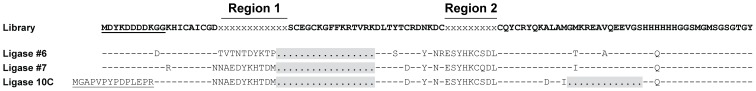
Sequence alignment of the library used as input for the original ligase selection with ligases #6, #7 [17] and 10C that were selected at 23°C and at 65°C, respectively [41], [42].The amino acids in regions 1 and 2 of the original library (on top) were randomized prior to the selection at 23°C and are shown as “x” [43]. Dashes symbolize amino acids that are identical to the starting library. A period highlighted in gray represents a deletion. The underlined N-terminal amino acids of the library and ligase 10C represent a Flag epitope tag and an E epitope tag, respectively.